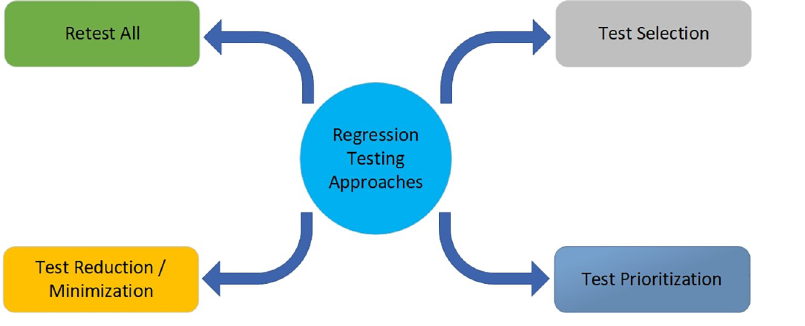
Fig 1. Regression testing